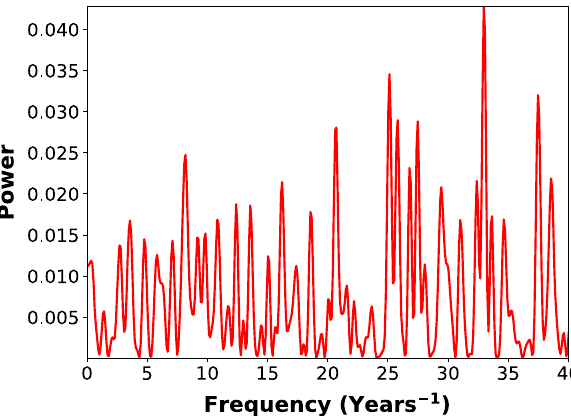
Fig. 2 Half-life time-series for 99m Tc (along with error bars) using the data from B18. The dashed horizontal lines indicate the ± 1 σ range for the data